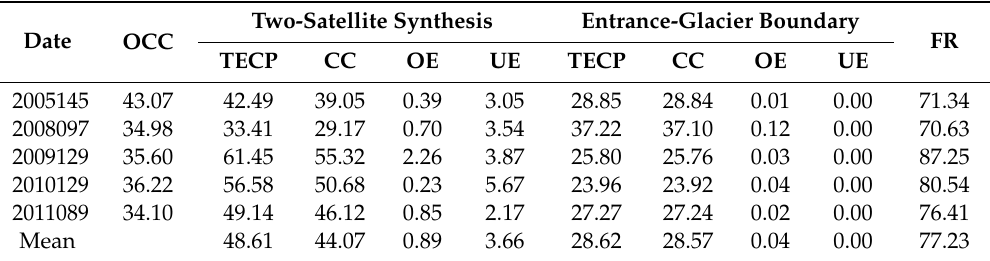
Table 2. Validation of eliminating cloudy pixels (unit: %). Two-Satellite Synthesis Entrance-Glacier Boundary OCC